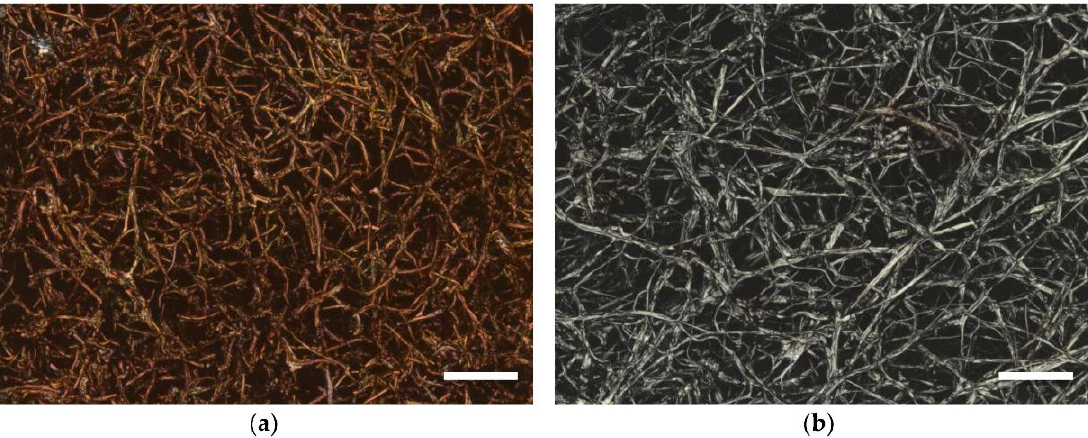
Figure 2. Confocal laser scanning microscopy (CLSM) images of oyster mushroom mycelium on polyacrylonitrile (PAN) nanofiber mats (the latter not visible) ( a ) after stabilization of the whole composite for 1 h at 280 °C; ( b ) after carbonization for 1 h at 500 °C of the whole composite. Scale bars indicate 20 µm. Reproduced from [19], published under a CC BY 4.0 license (MDPI, Basel, Switzerland).